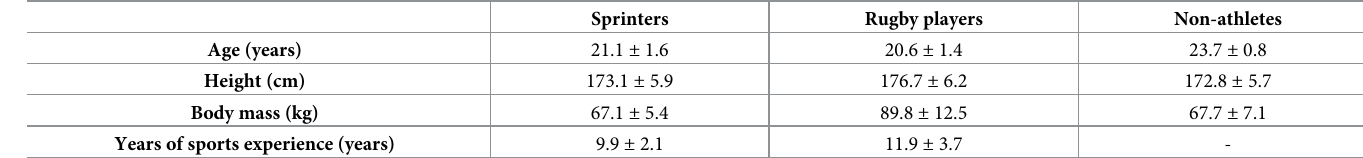
Table 1. Anthropometrics and training profiles of the sub-elite sprinters (n = 14), rugby players (n = 14), and non-athletes (n = 14).